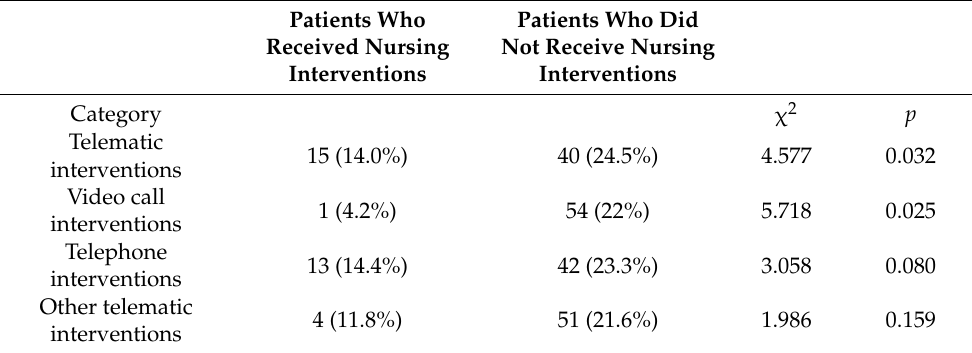
Table 3. Analysis of hospital admissions in the six months following lockdown.